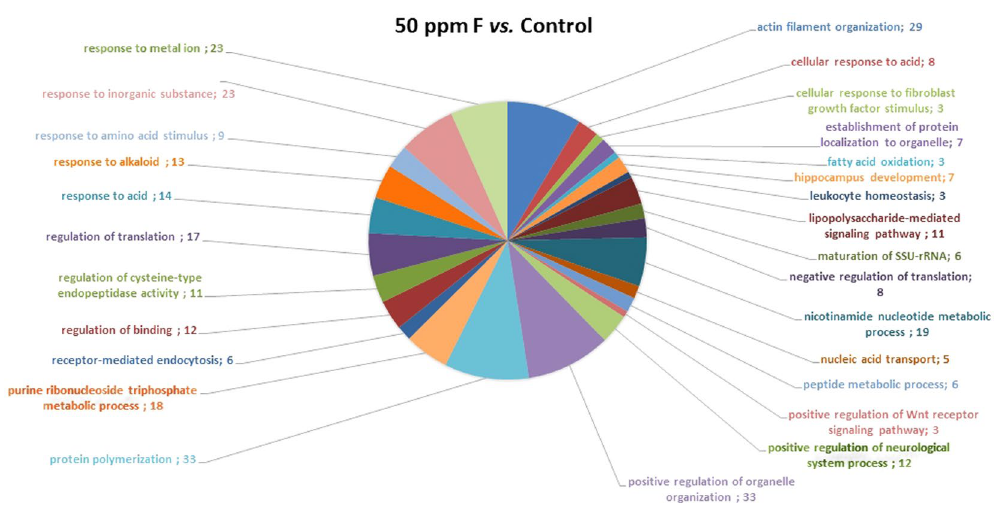
Figure 2. Functional distribution of proteins identified with differential expression in the duodenum of rats exposed chronically to 50 ppm F vs. Control Group (0 ppm F). Categories of proteins based on GO annotation Biological Process. Terms significant (Kappa = 0.04) and distribution according to percentage of number of genes association. Proteins access number was provided by the UNIPROT. The gene ontology was evaluated according to ClueGo ® pluggins v2.0.7 of Cytoscape ® software 36, 37